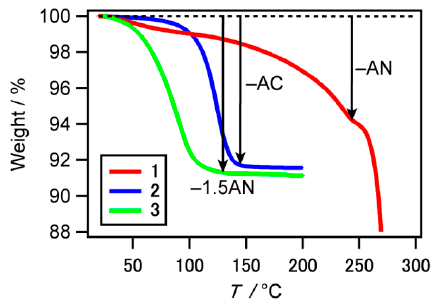
Figure 2. TG curves for compounds 1 (red), 2 (blue), and 3 (green). The scan rate was 2 K·min − 1 . After cooling the measured samples, compounds 1 and 3 turned to be a powder